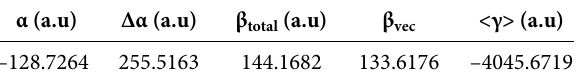
Table 4 dipole polarizability (α), first and second hyperpolarizabili- ty (β, γ), the vector component of first hyperpolarizability (β vec ) and the anisotropy of the polarizability (∆α) of the title compound α